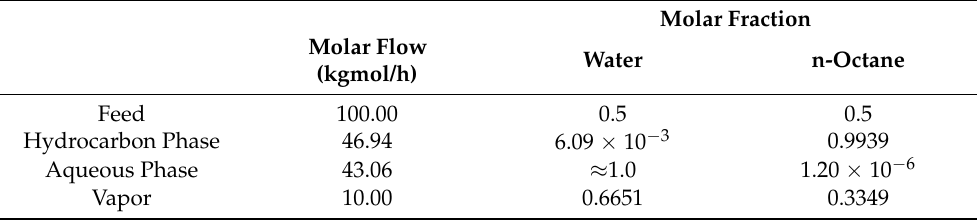
Table 4. HYSYS V9 results for three-phase flash calculations at T = 80 ◦ C using SRKKD.